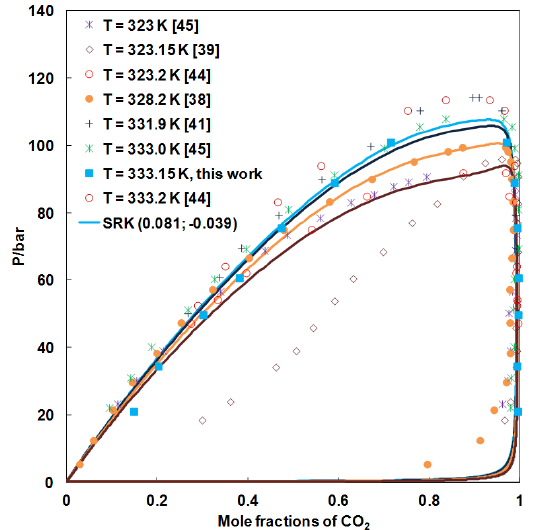
Figure 1. Comparison of new experimental data and literature data for the carbon dioxide + 2-methyl-1-propanol (isobutanol) system and calculations by SRK model: symbols, new data and literature data at different temperatures; solid lines, predictions by SRK ( k = 0.081, l = 12 12